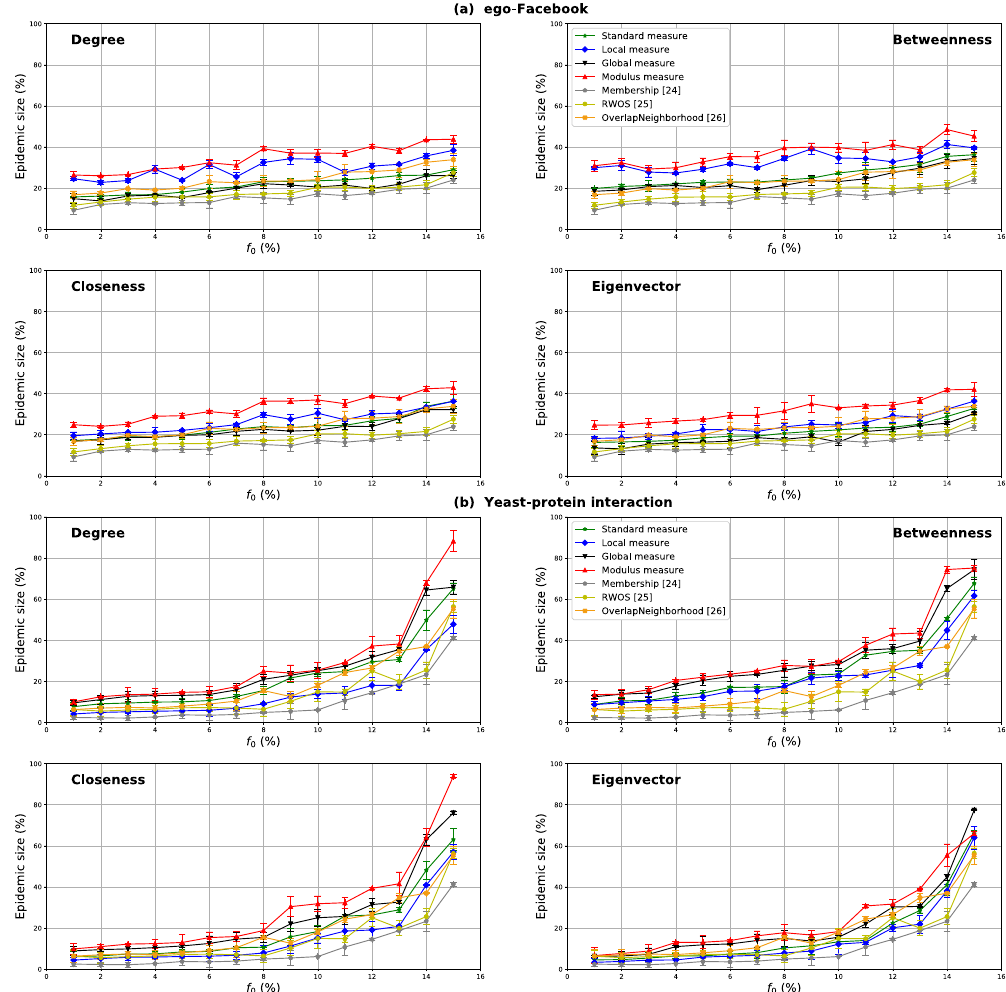
Figure 19. The epidemic size as a function of the fraction of initial spreaders f 0 . The standard and the modular variations of Degree, Betweenness, Closeness and Eigenvector centrality measures as well as some alternative measures (Membership, RWOS and Overlap Neighborhood) are tested on two real-world networks of different community structure